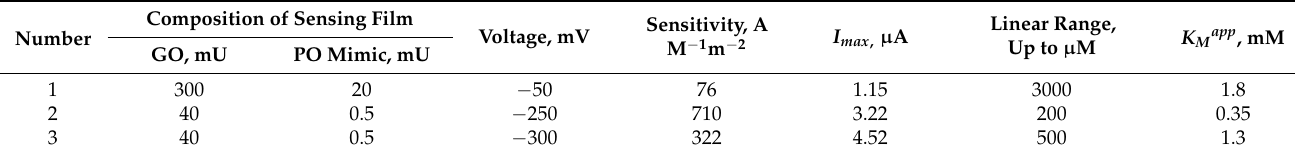
Figure 7. Characteristics of the GO/gCuHCF/GE under different working potentials: ( a , b )—dependences of the current response on increasing concentrations for glucose determination; ( c , d )—calibration graphs. Conditions: working potentials − 250 ( a , c ) and − 300 mV ( b , d ) vs. Ag/AgCl (reference electrode), 50 mM phosphate buffer, pH 6.0 at 23 ◦ C. The GE contains 0.5 mU of PO-like activity and 40 mU GO. Table 4. Analytical characteristics of the developed